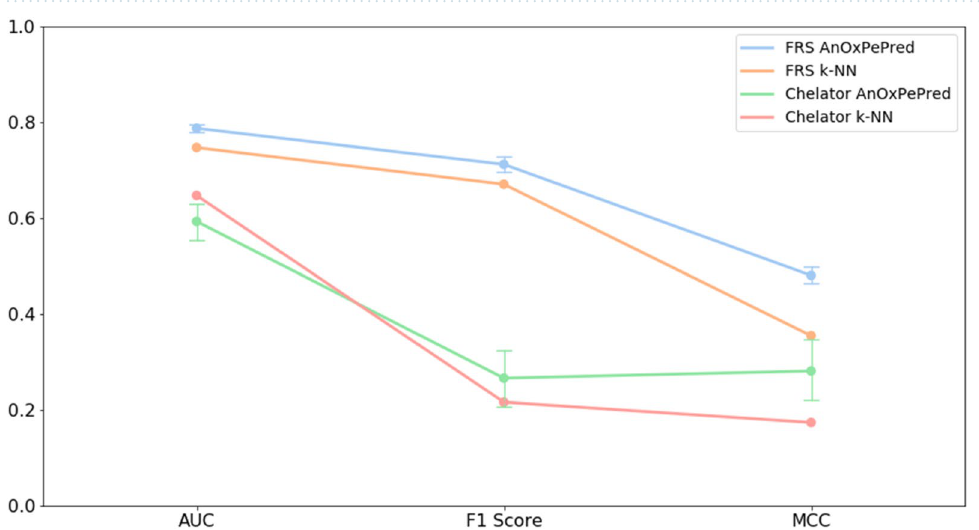
Figure 5. Performance comparison of AnOxPePred and k-NN for both FRS and chelating properties using the metrics AUC, F1 score and MCC. AUC area under the curve, MCC Matthew’s correlation coefficient, FRS free radical